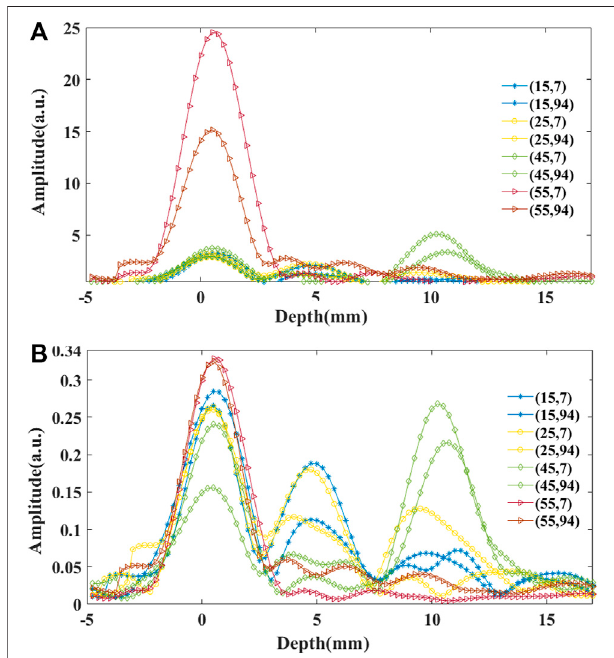
FIGURE 5 | THz A-scan images of depth direction at different positions. (A) Raw data. (B) Normalised